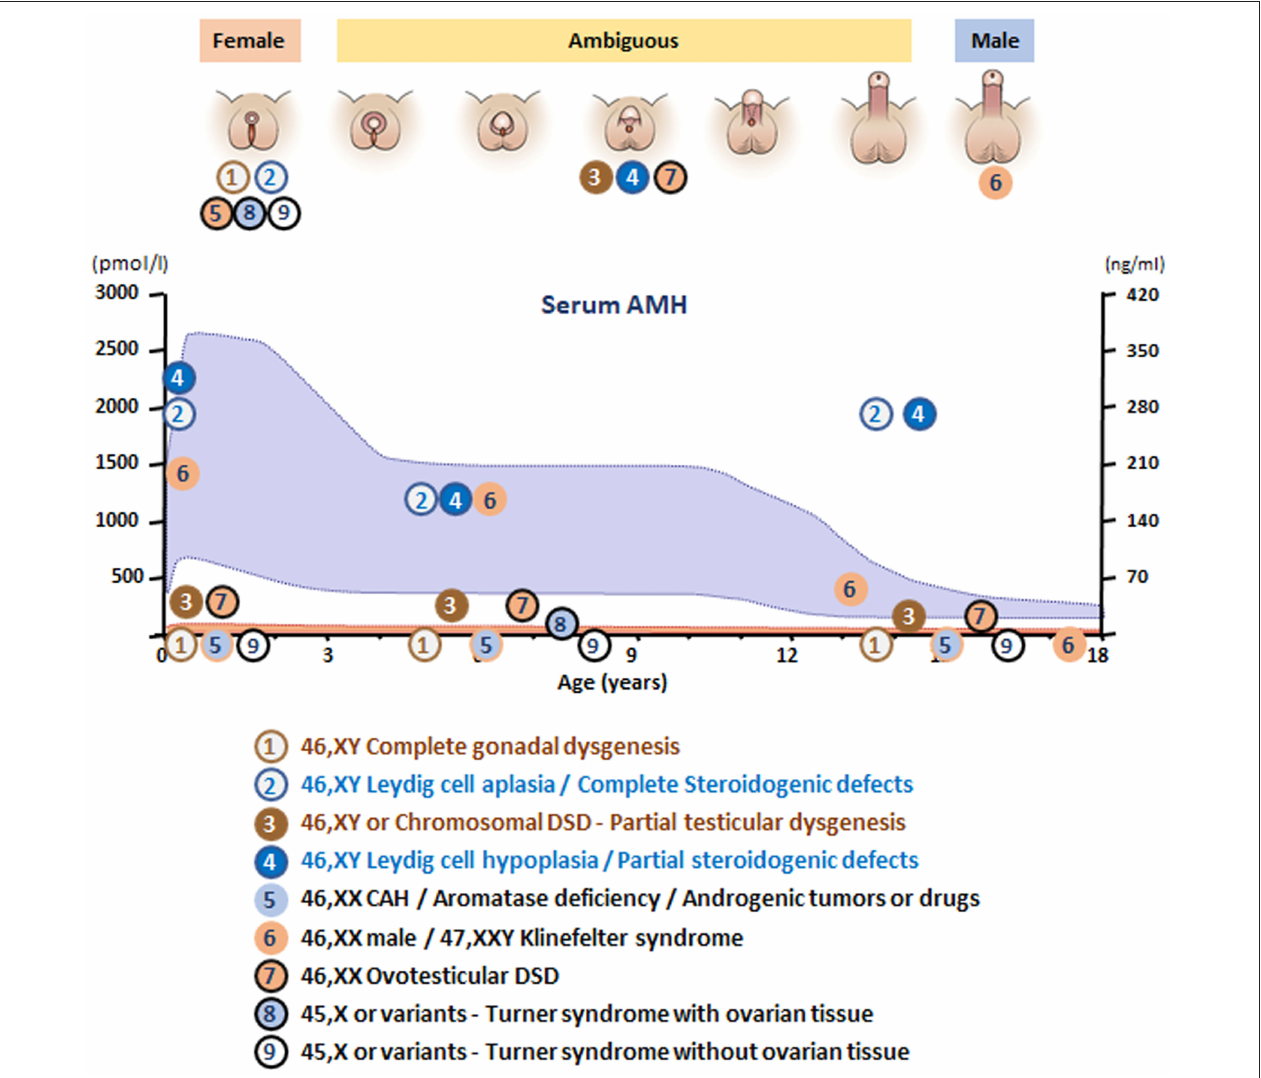
FIGURE 6 | Schematic of AMH levels in various types of disorders of sex development (DSD) in relationship to the aspect of the external genitalia and age. The shaded area represents reference levels for AMH, as obtained from ref. ( 22).